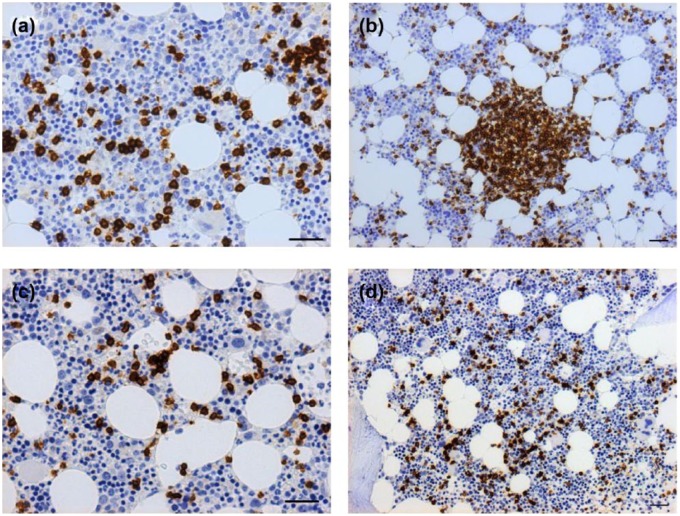
B- and T-cell infiltrates and nodules in bone marrow trephines from
patients with MS. (a, b) Both CD3-positive and (c, d) CD20-positive
infiltrates were noted. The majority of MS trephines had (b) T-cell
nodules but few samples had CD20-positive nodules. Scale bar:
100 µm.